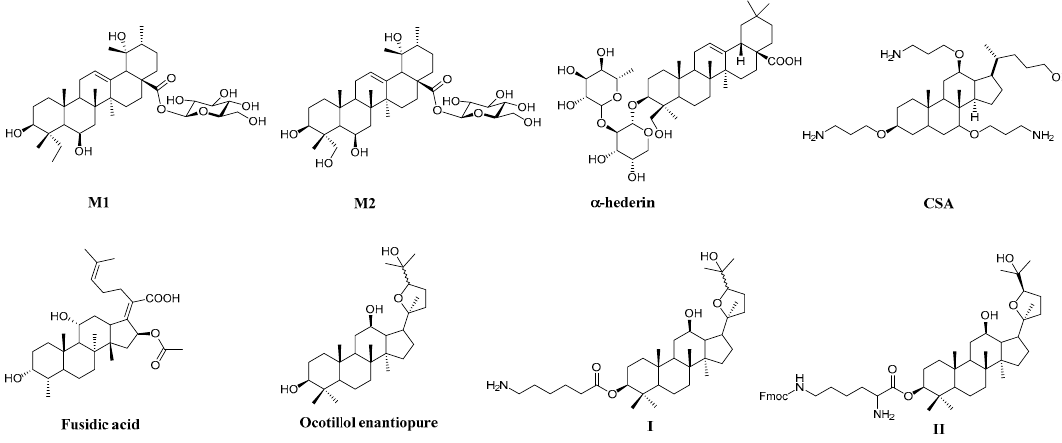
Figure 1. The structures of the extract from Dolichandrone spathacea ( M1 , M2 ), α -hederin, CSA , Fusidic acid, Ocotillol enantiopure, I and II